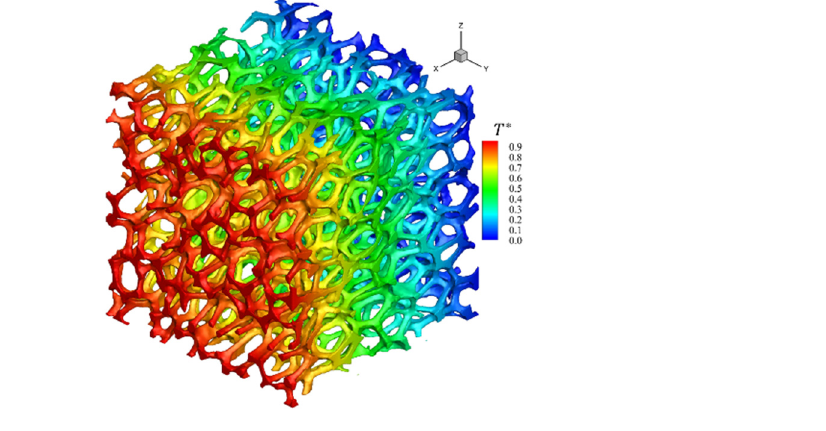
Figure 8. The dimensionless temperature distribution of foam copper skeletons when heating in the x direction at k r = 10.